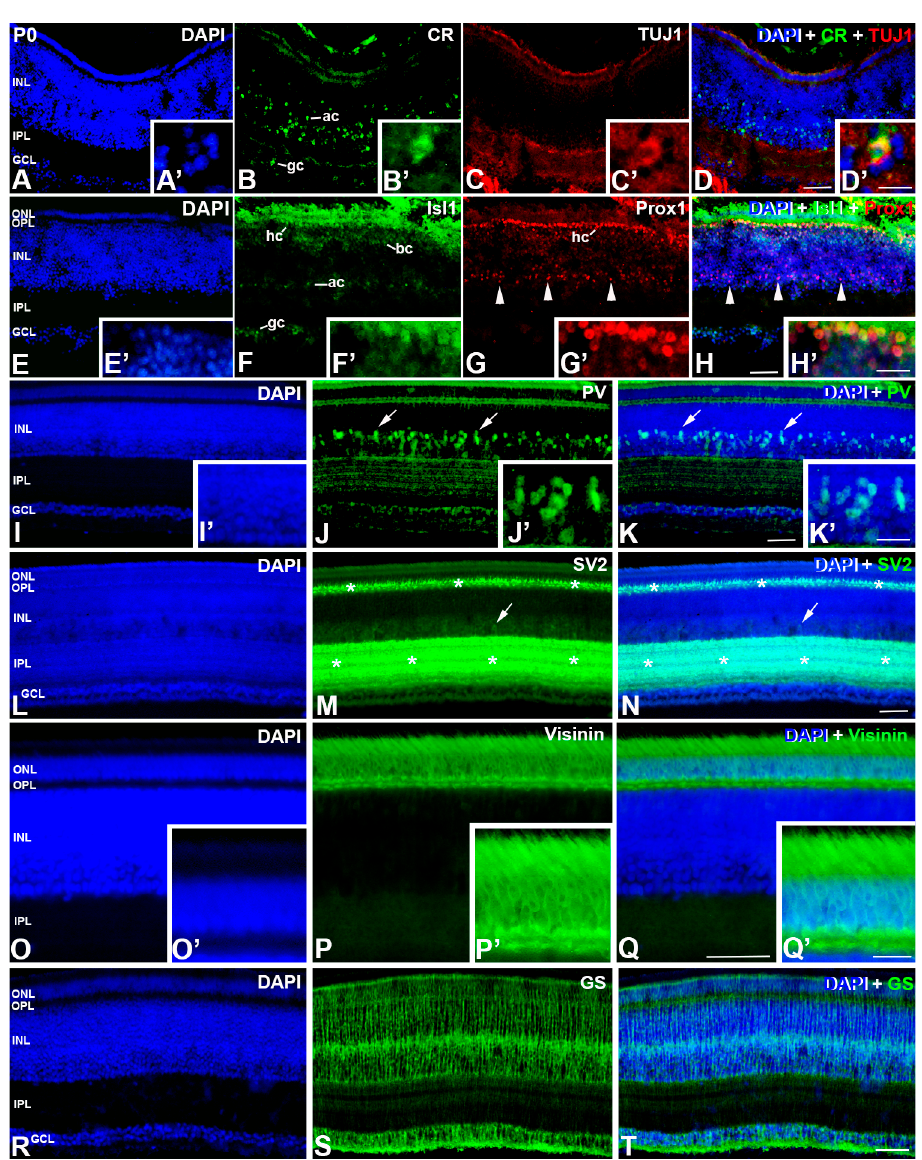
Figure 7. Immunoexpression of di ff erent cell markers in retinal cryosections of C. coturnix at P0. An increase of amacrine cells CR and TUJ1-immunoreactive is detected ( B – D ). Co-expression of these markers is found in some of the ganglion cells ( B ′ – D ′ ). Ganglion, amacrine, bipolar and horizontal cells are Isl1-positive ( F , H ). Prox1-immunoreactivity can be localized in horizontal cells ( G , H ) as well as in some horizontal cell precursors (arrowheads in ( G , H )). Co-staining with Islet1 and Prox1 can be detected in a subpopulation of horizontal cells ( F ′ – H ′ ). A mature multilayered tissue with amacrine cells and PV-immunoreactive can be detected in the INL. ( J , K , J ′ , K ′ ). Plexiform layers (asterisks in ( M , N )) can be localized because of the SV2 antibody as well as some amacrine cells (arrows in ( M , N )). Visinin expression is detected in mature photoreceptors ( P , Q ) that exhibits outer segments ( P ′ , Q ′ ). An intense GS-immunosignal is observed in the somata and feet of Müller cells ( S , T ). GCL, ganglion cell layer; INL, inner nuclear layer; IPL, inner plexiform layer; ONL, outer nuclear layer; OPL, outer plexiform layer. Scale bars: 100 µm in ( A – T) ; 50 µm in ( I ′ – K ′ ), ( O ′ – Q ′ ); 30 µm in ( A (cid:48) – H (cid:48)